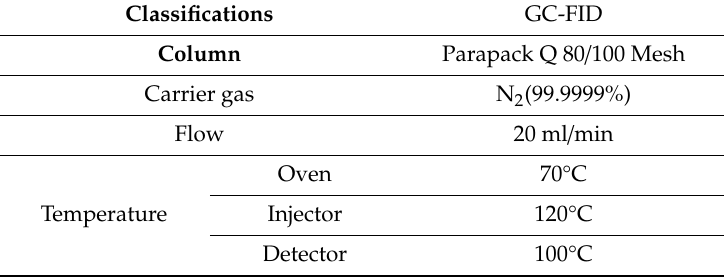
Table 3. Condition of gas chromatography-flame ionization detector (GC-FID) for CH 4